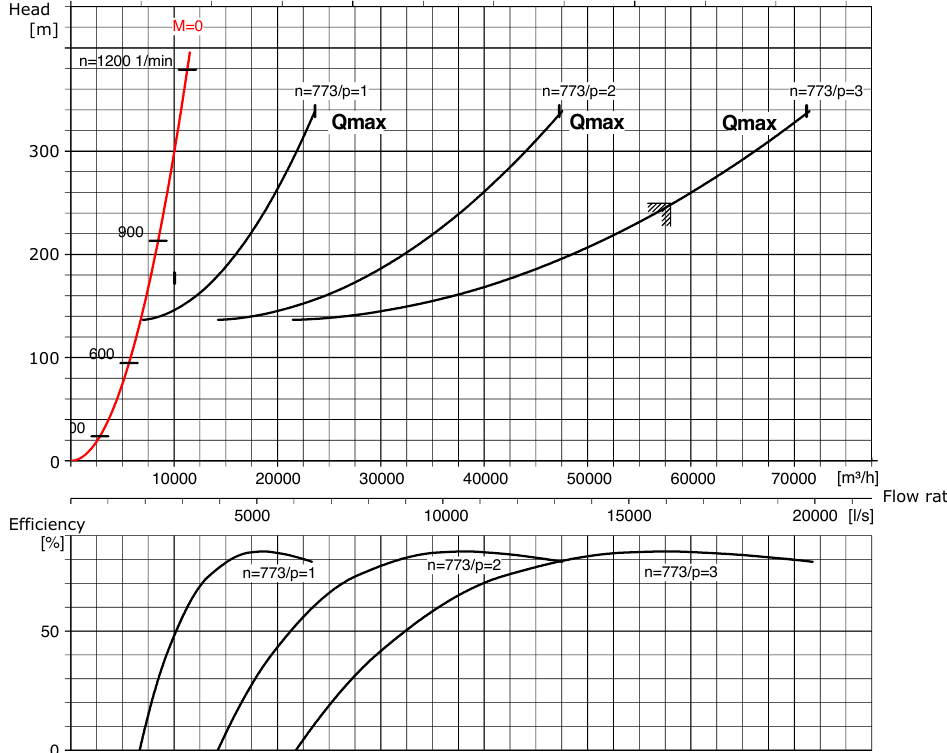
Figure 6. Performance estimation of the 3 double suction PATs in parallel (p = 3) under 250 m gross head. In the graph other characteristic curve are presented: performance for two PATs in parallel (p = 2) and a single PAT (p = 1). In red, the runaway limit in which in no positive torque is